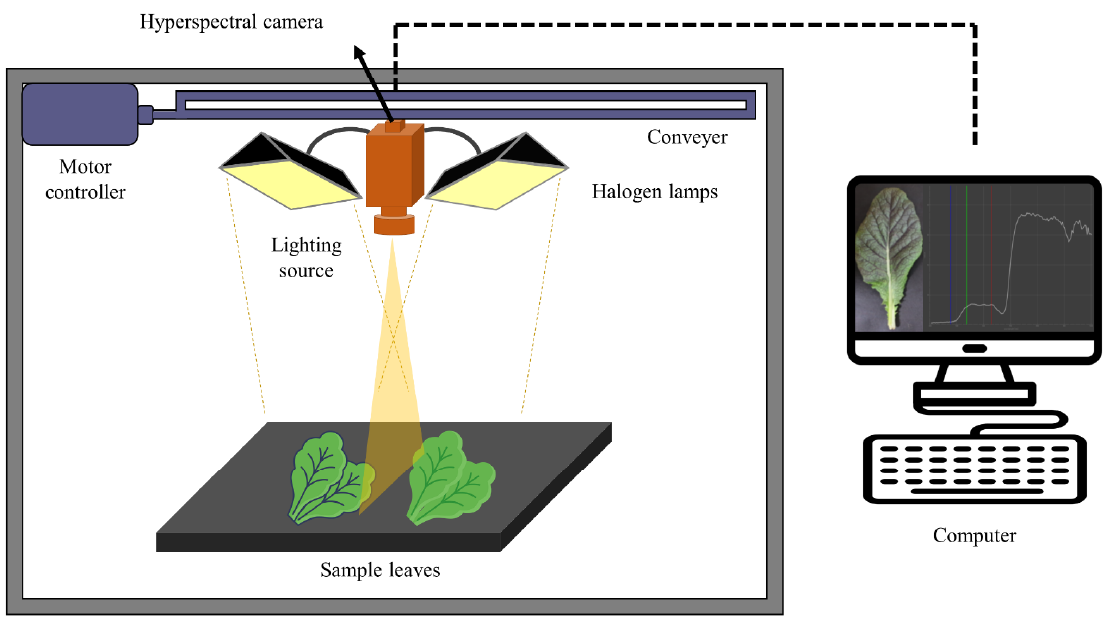
Figure 2. Hyperspectral imaging system (HSI) and extraction of spectral data from computer.